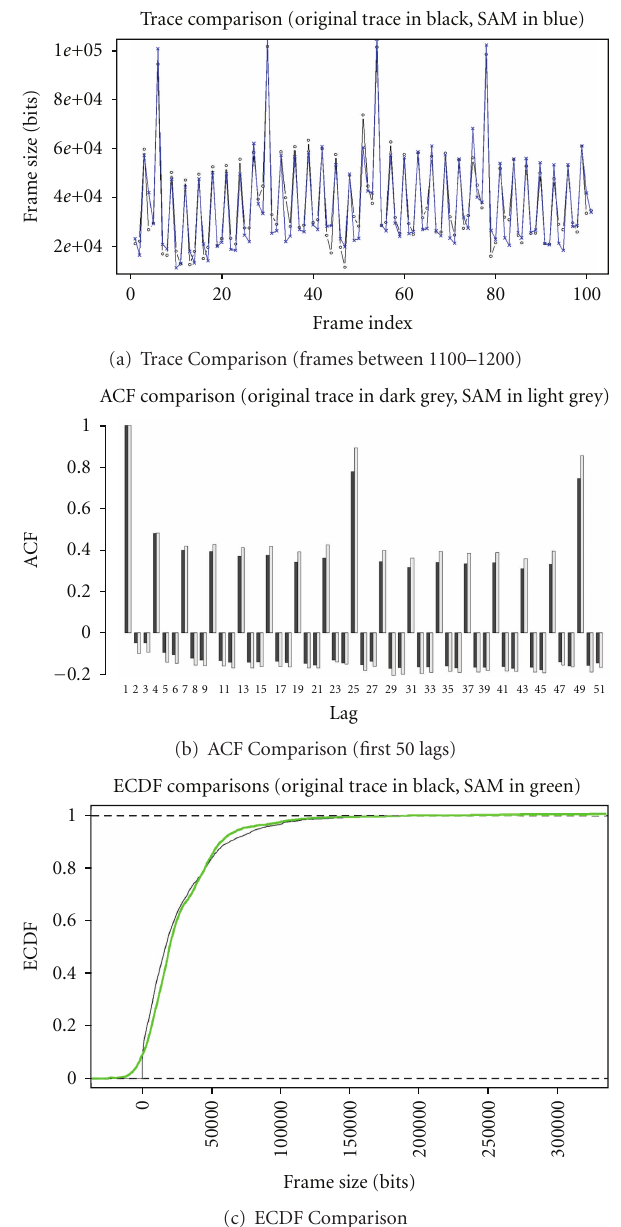
Figure 11: An example of SAM trace analyzer generated comparison